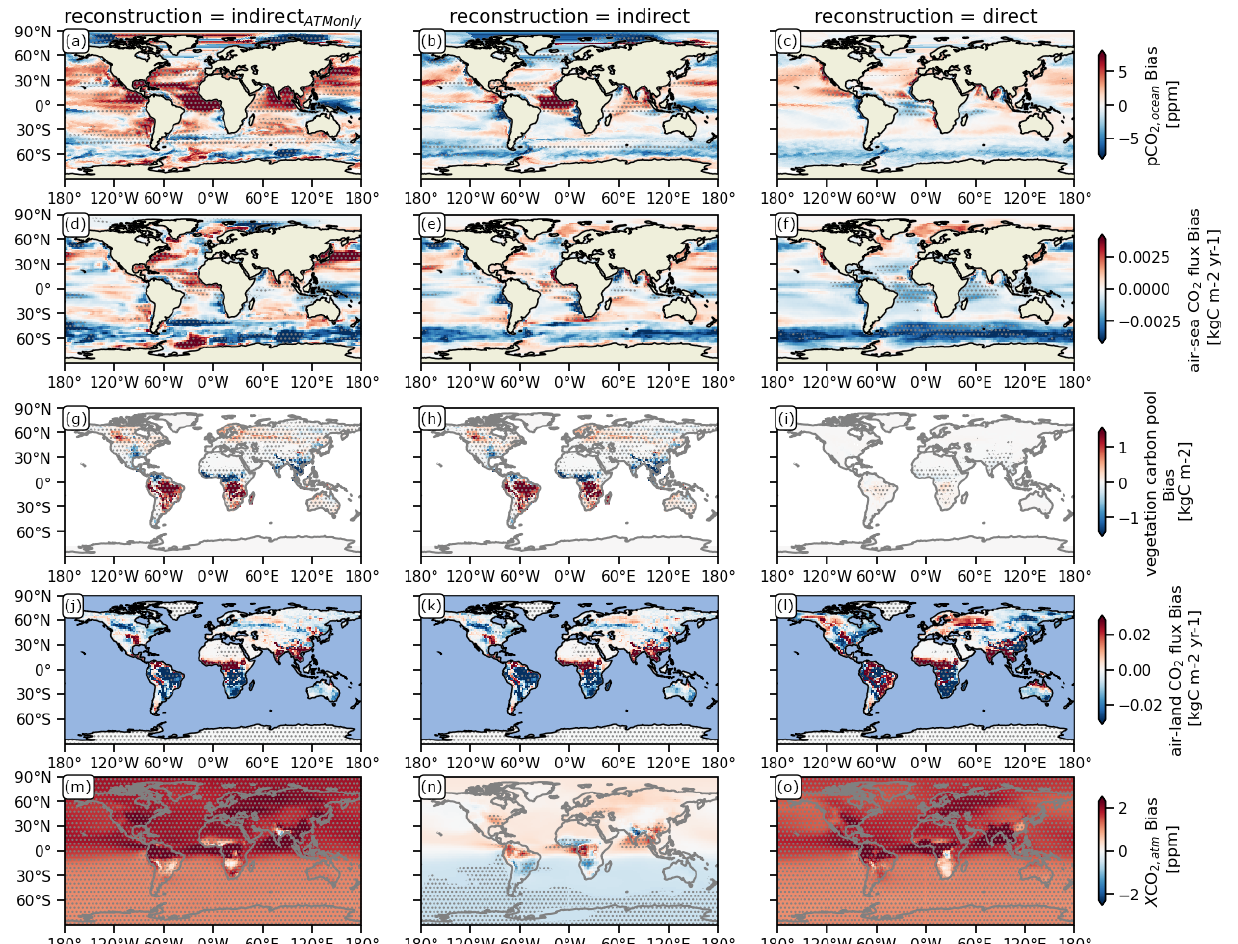
Figure 2. Spatial distribution of the bias between the target and different indirect carbon cycle reconstruction methods over 10-year running windows of annual means (see Appendix A). Columns show the different carbon cycle reconstruction methods (see Table 1). Rows show the different variables: the ocean carbon cycle is represented by (a–c) the partial pressure of surface CO 2 in the ocean ( p CO 2 ) and (d–f) surface air–sea CO 2 flux (negative values indicate carbon uptake by the ocean); the land carbon cycle is represented by (g–i) the vegetation carbon pools and (j–l) air–land surface CO 2 flux (negative values indicate carbon uptake by land); and the atmospheric carbon is represented by (m– o) the atmospheric CO 2 mixing ratio ( X CO 2 ). Gray stippling shows where the bias exceeds the 5th-percentile mean absolute error threshold from random target block resampling, i.e., the reconstruction is not significantly better than internal